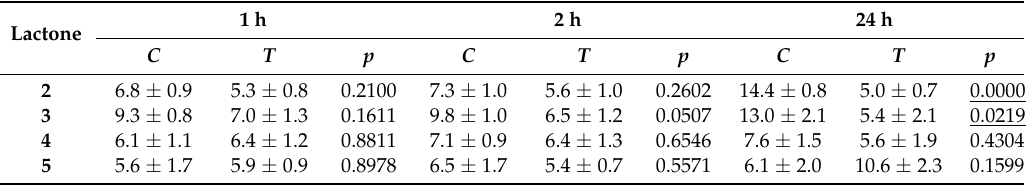
Table 4. Deterrent activity of lactones 2 – 5 . Numbers for C = control and T = treated represent mean number (±SE) of aphids that settled on the control or the treated leaf (choice ‐ test) 1 h, 2 h, and 24 h after exposure. p —significance level (Student’s t ‐ test; StatSoft, Inc. (2014) STATISTICA)—significant differences ( p < 0.05) between the number of aphids settled on either leaf are underlined.